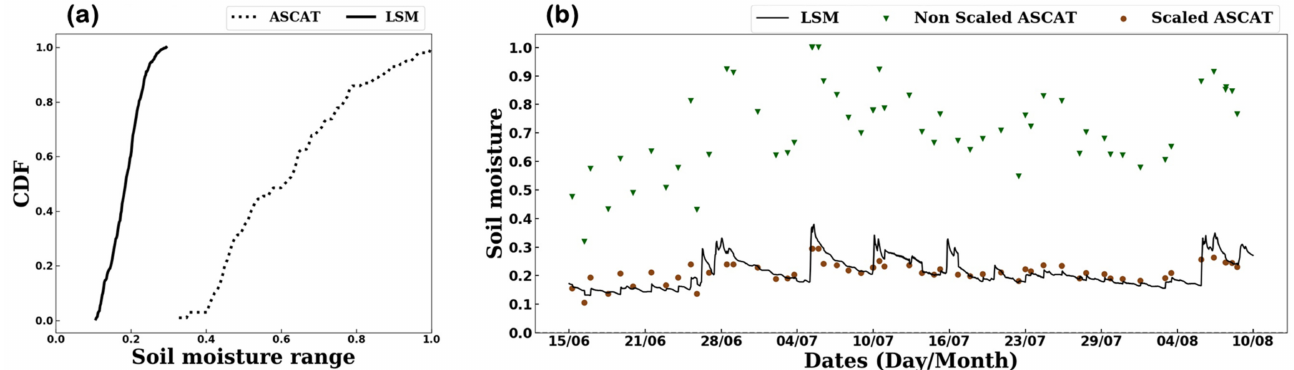
Figure 2. ( a ) CDF estimates of the ASCAT soil wetness (solid line) for July and LSM volumetric soil moisture (dashed line) from 2016 to 2018 at 44.625 ◦ N, 120.875 ◦ E. For this location: ( b ) hourly time series of the non-scaled ASCAT soil wetness (green dots) and scaled ASCAT volumetric soil moisture (brown dots) against the stand-alone LSM volumetric soil moisture (black line).